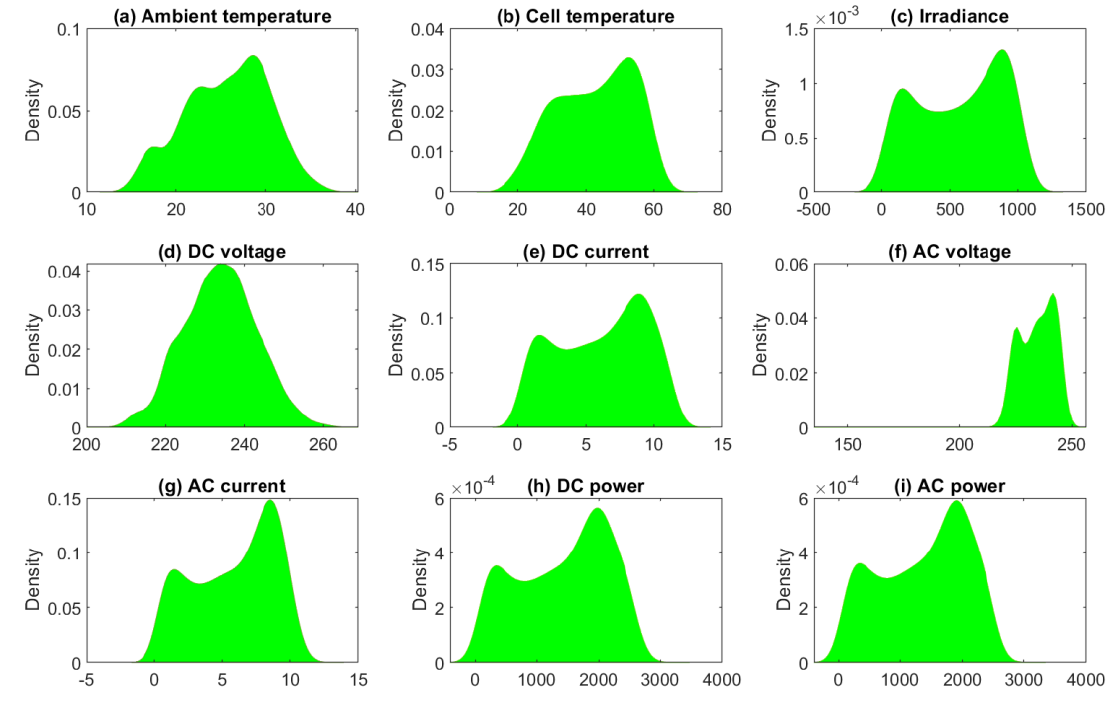
Figure 7. Distribution of the considered variables.